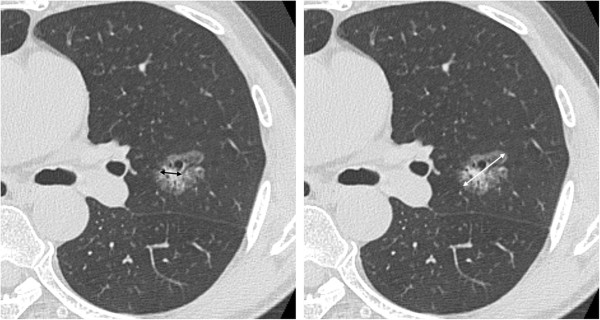
Example of the consolidation/tumor (C/T) ratio measurement on thin-section computed tomography. C/T ratio (%) = maximum diameter of consolidation (black arrow)/maximum diameter of tumor (white arrow) × 100.